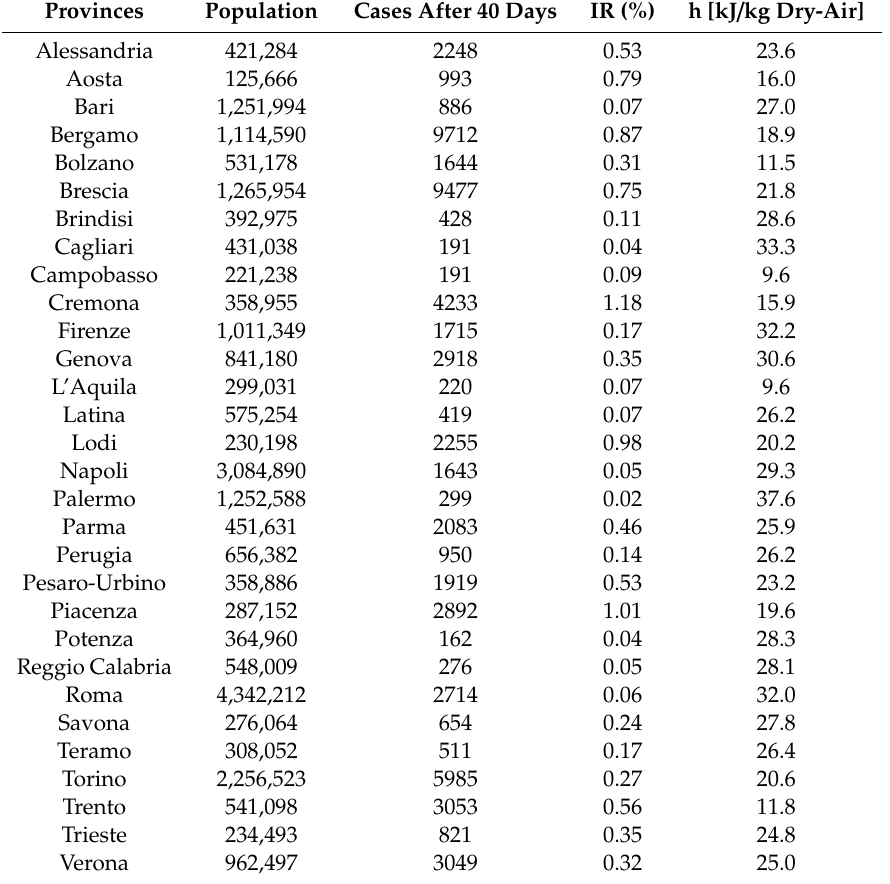
Table 1. Data from the 30 selected Italian